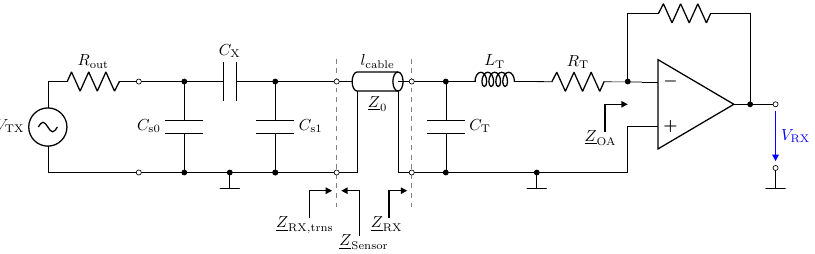
Figure 21. Resonant receiver circuit connected to a capacitive Π -network by means of a transmission line with length l cable and impedance Z 0 = 50 Ω . R out = 50 Ω , R f = 500 Ω , C X = 1pF, C s0 = C s1 =